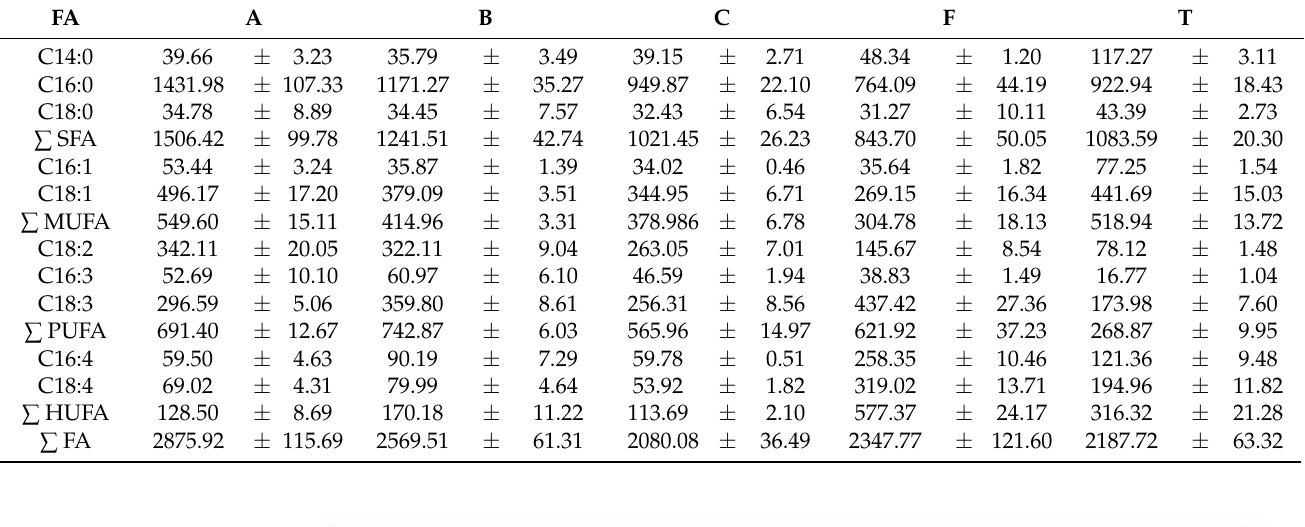
Table 2. FA content expressed (in µ g.g − 1 d.w.) of Ulva sp. from different cultivation tanks or wild: indoor aquaria (A, B, and C), outdoor tank (T), and harvested from the field (F). Data as mean ± SEM; n = 3.